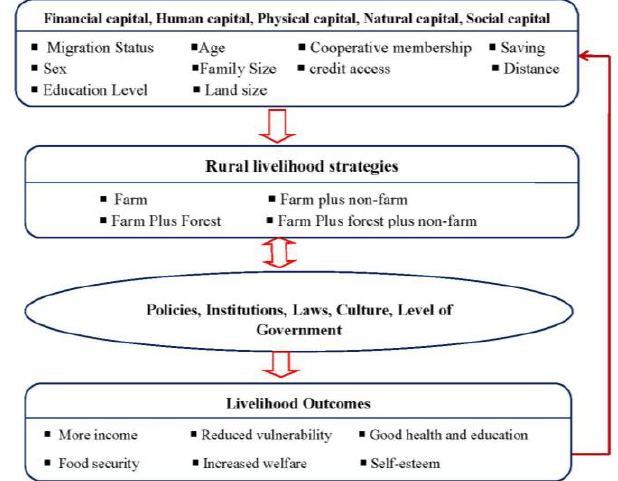
Fig. 1. Conceptual framework of rural households’ livelihood strategies (Source: adopted from DFID,